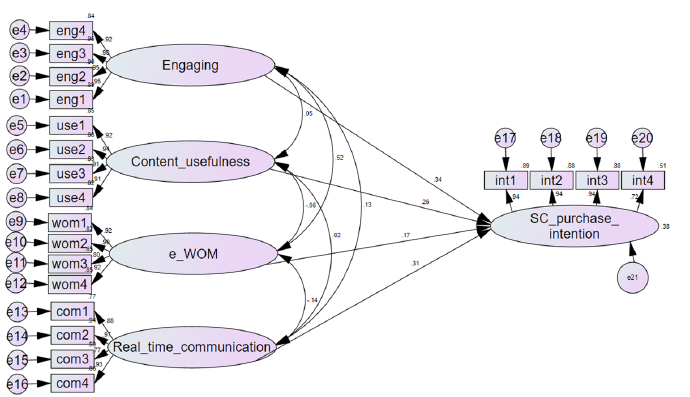
Fig. 2. Structural model for testing the